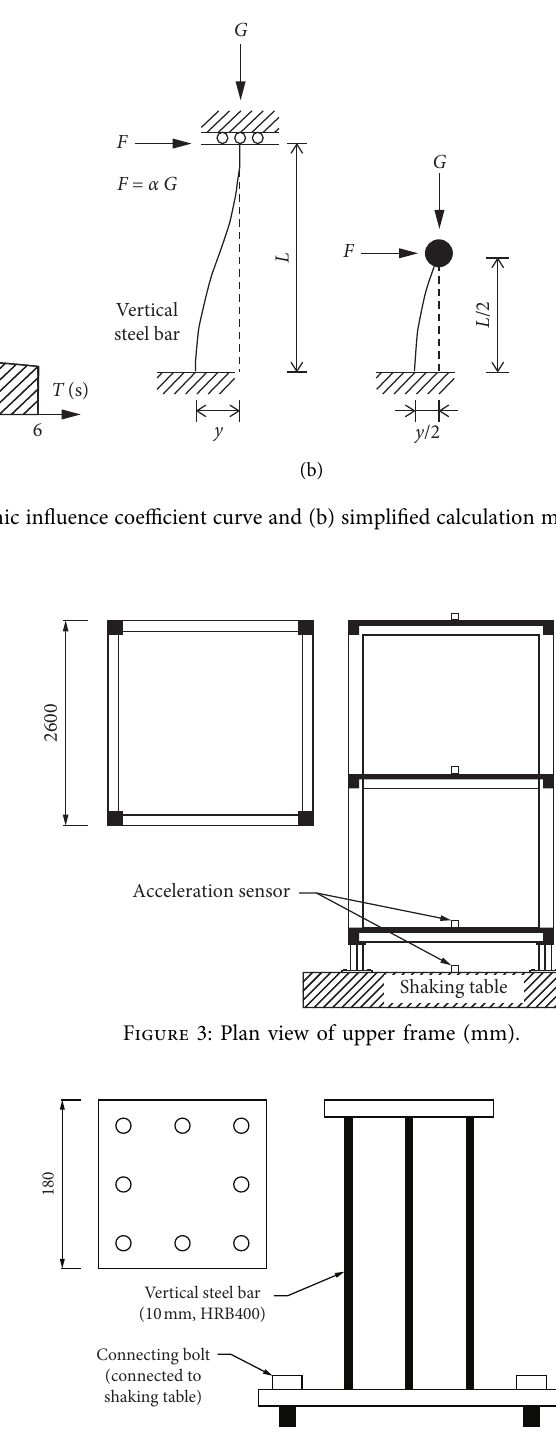
Figure 4: Size and structure of rebar isolation pier in this text (mm).